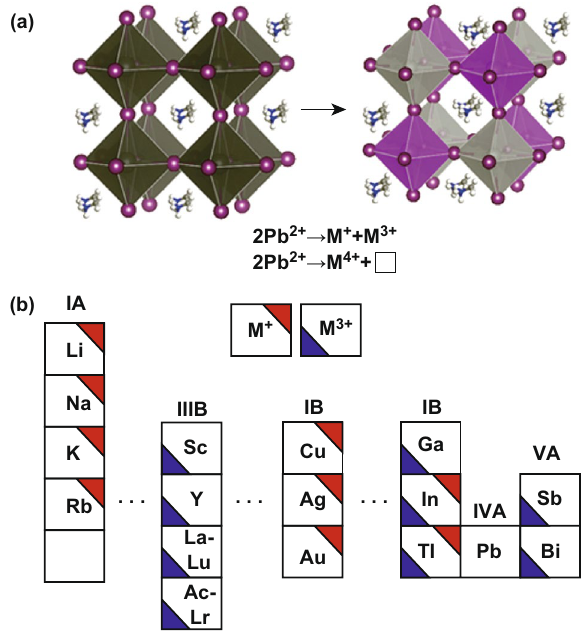
Fig. 1 a Schematic illustration of the transformation from APbX 3 to A 2 M(I)M(III)X 6 or A 2 M(IV)X 6 , where two toxic Pb 2+ ions are sub- stituted by combining M + and M 3+ ions (or M 4+ ion). “ □ ” denotes M-site vacancy. b Elements of M-location cations with M + and M 3+ in the periodic table for halide double perovskites. When any M-site elements are localized at IA or IIIA groups of the periodic table, the materials have direct